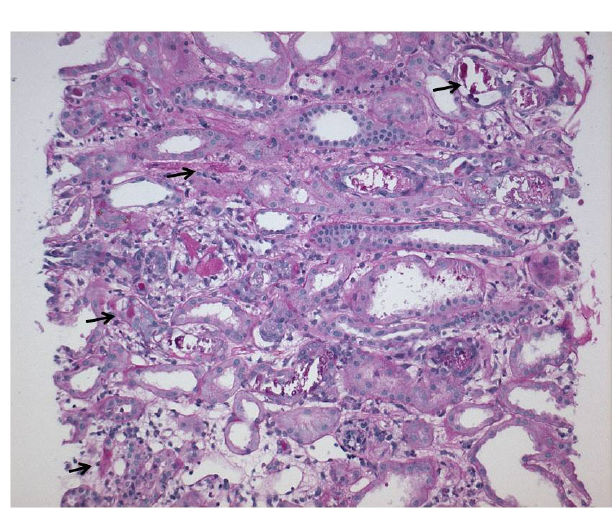
Figure 1. Kidney biopsy – showing numerous tubules with calcification (black arrows) (PAS stain, magnification x100) [Courtesy: Andrew Herzenberg (deceased) and John Rohan, University Health Network, Toronto, Ontario, Canada]. This report further highlights the need for vigilance when using OSP solutions for bowel preparation or to relieve constipation. Alternative solutions should be considered, especially in elderly and high-risk individuals 5